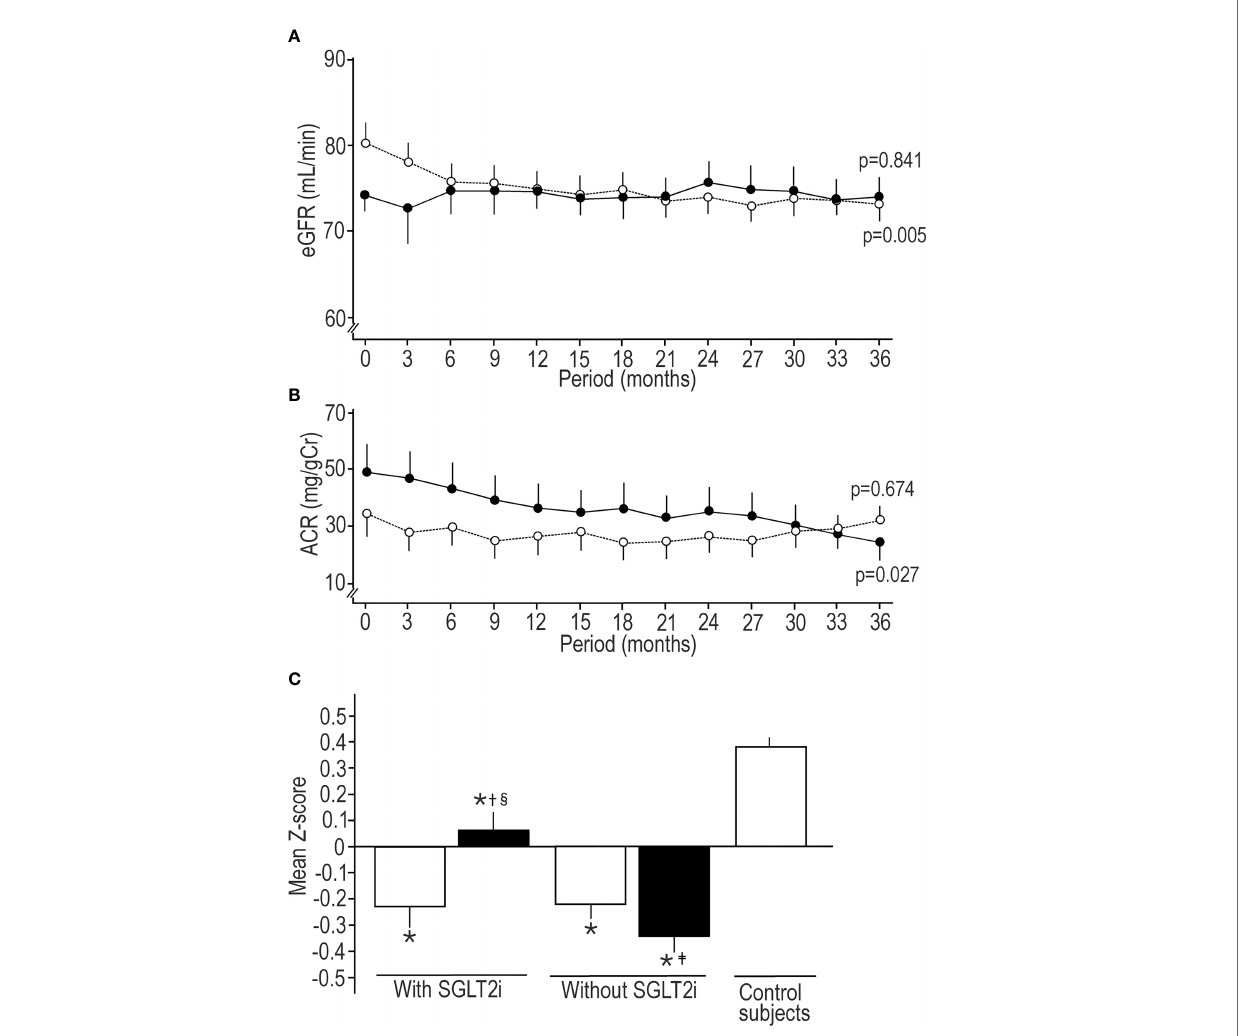
FIGURE 1 | Sequential changes in estimated glomerular fi ltration rate (A) and albumin to creatinine ratio (B) in patients treated by SGLT2i (solid circle) and treated without SGLT2i (open circle). Values were mean ± standard error of the mean. The trend of decrease was assessed by Jonckheere-Terpstra test, and p value presents the signi fi cance of trend. (C) Comparison of mean Z-score of 8 neurophysiological tests (median motor nerve conduction velocity and amplitude, sural sensory nerve conduction velocity and amplitude, vibration perception threshold, coef fi cient of variation of R-R interval, warm perception threshold, and cold perception threshold) among patients treated with or without SGLT2i at the baseline and endpoint and healthy control subjects at the baseline. Open column; at the baseline, solid column; at the endpoint. Values were mean ± standard error of the mean. *p < 0.001 compared with control subjects, † p < 0.001 compared with baseline, ‡ p < 0.05 compared with baseline, § p < 0.05 compared with patients without